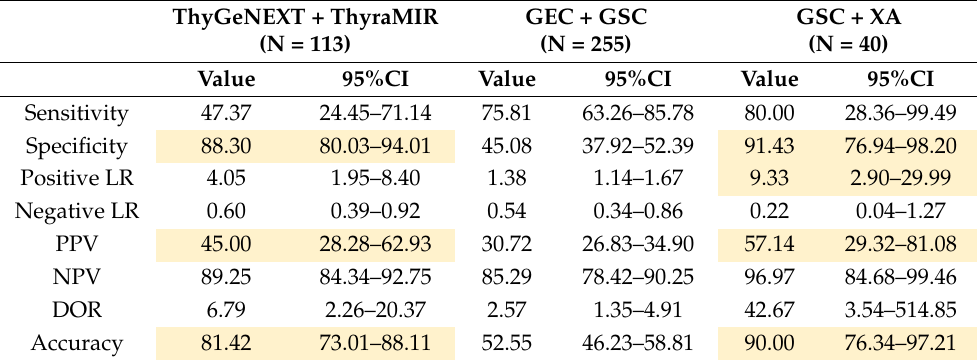
Table 2. Diagnostic accuracy of nodules undergoing the ThyGeNEXT + ThyraMIR, GEC + GSC, and GSC + XA molecular